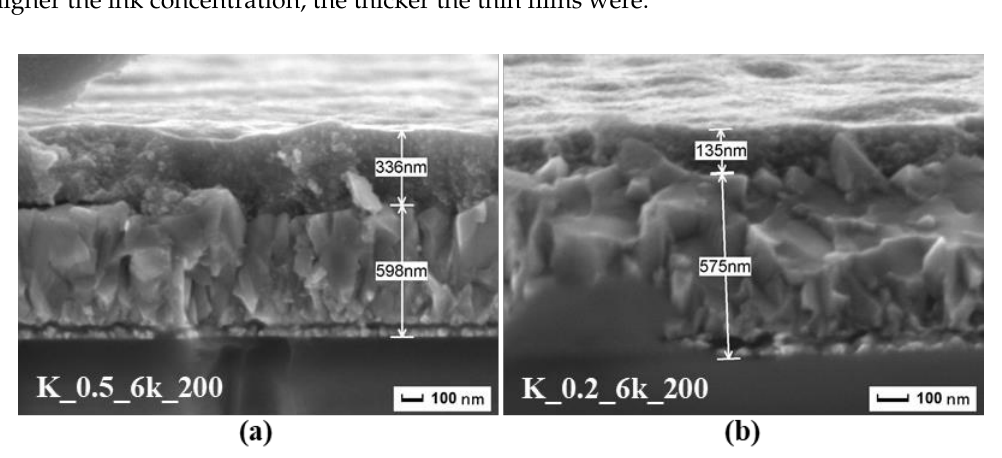
Figure 2. Cross-section of the CZTS thin film on fluorinated tin oxide (FTO) glass by SEM, prepared with ink having concentrations of ( a ) 0.5 g/mL and ( b ) 0.2 g/mL, respectively.